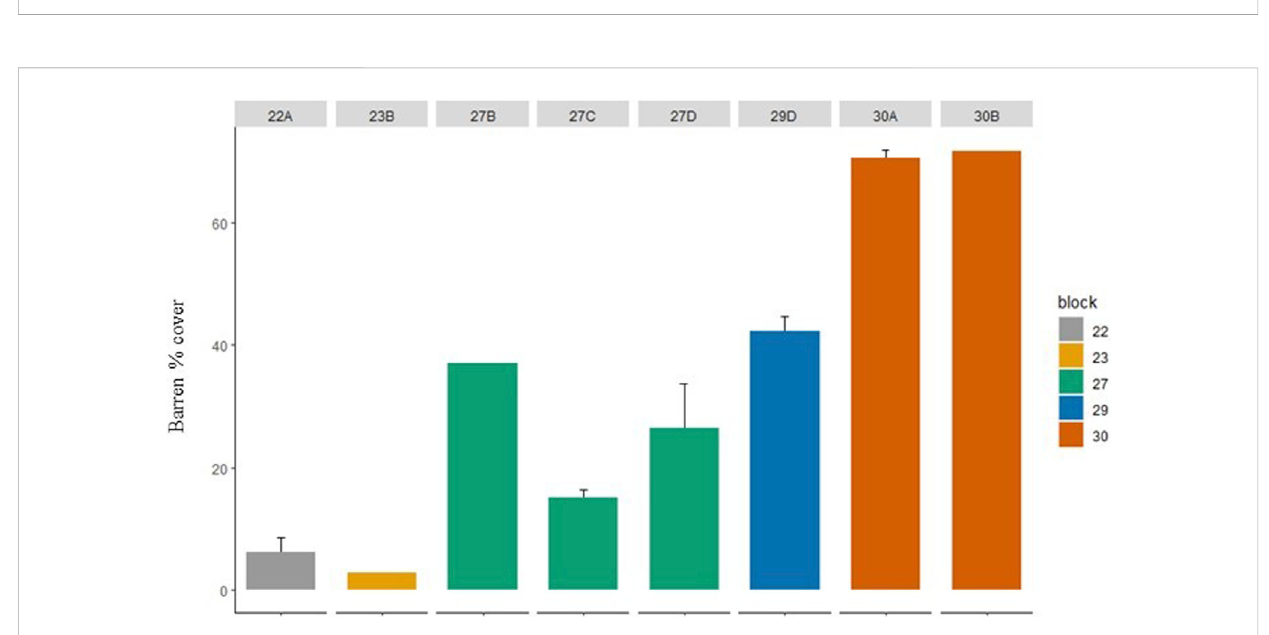
FIGURE 5 Mean (±SE)% of reef estimated to be covered by “ complete ” barren across abalone management blocks.